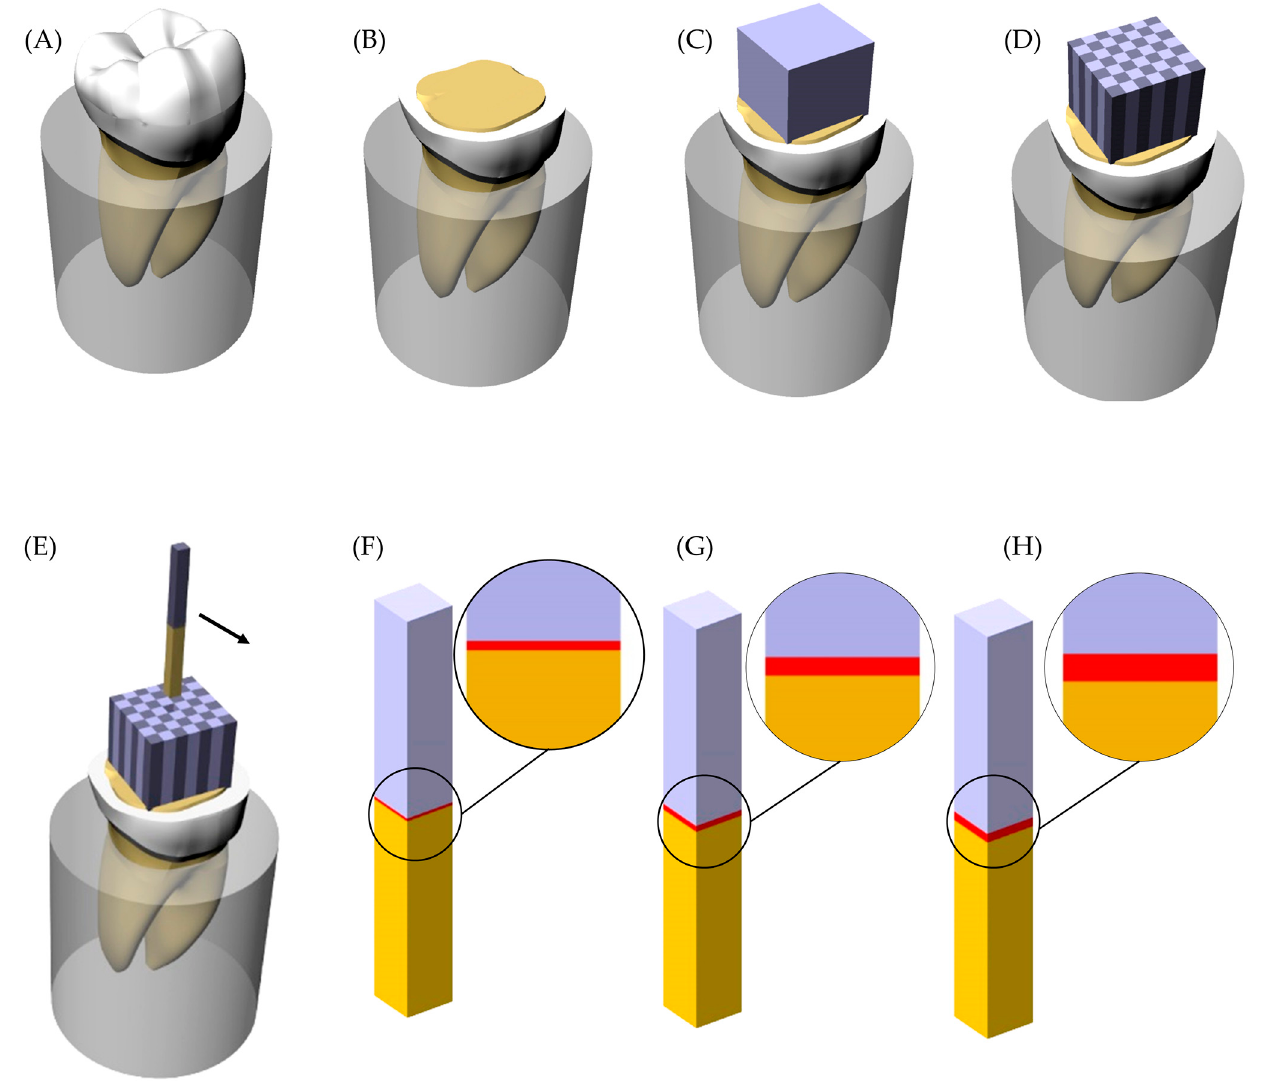
Figure 1. Sample preparation scheme and groups. ( A ) Sound tooth embedded into acrylic resin; ( B ) Flattened tooth with exposed dentin tissue; ( C ) Lithium disilicate glass-ceramic block cemented; ( D ) Sectioned sample with the beams separated; ( E ) Beam removed from the position; ( F ) Groups with 60 µ m of cement layer thickness; ( G ) Groups with 120 µ m of cement layer thickness and ( H ) Groups with 180 μ m of cement layer thickness.